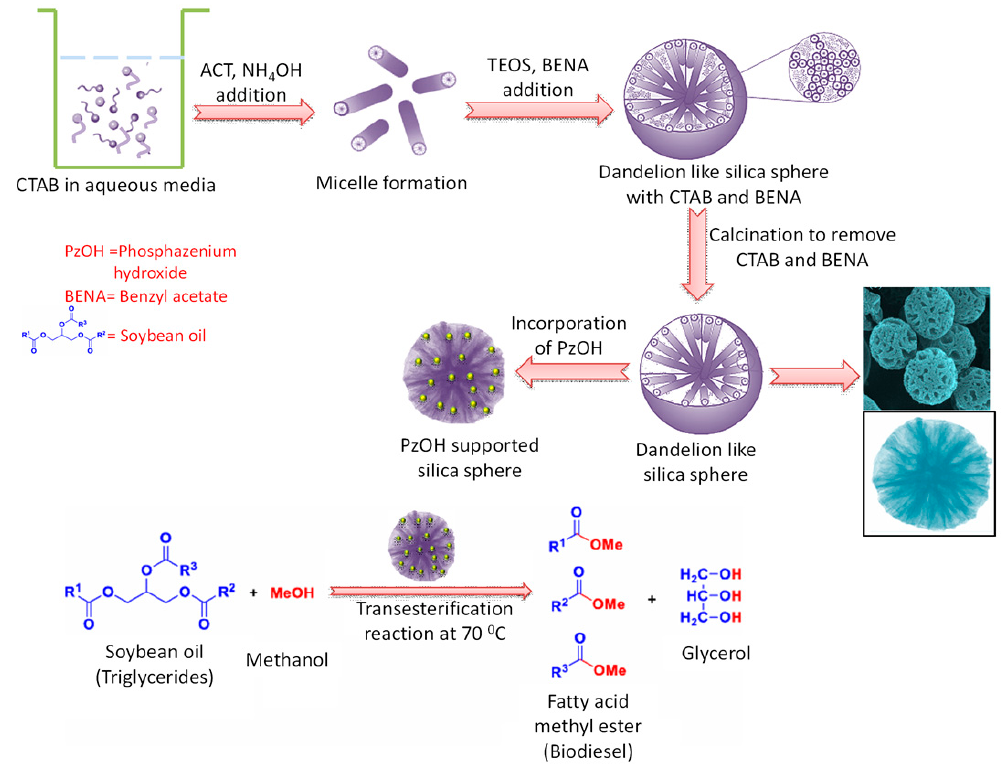
Figure 10. Synthesis of dandelion type silica sphere, PzOH incorporation, and catalytic transesterification reaction over it.